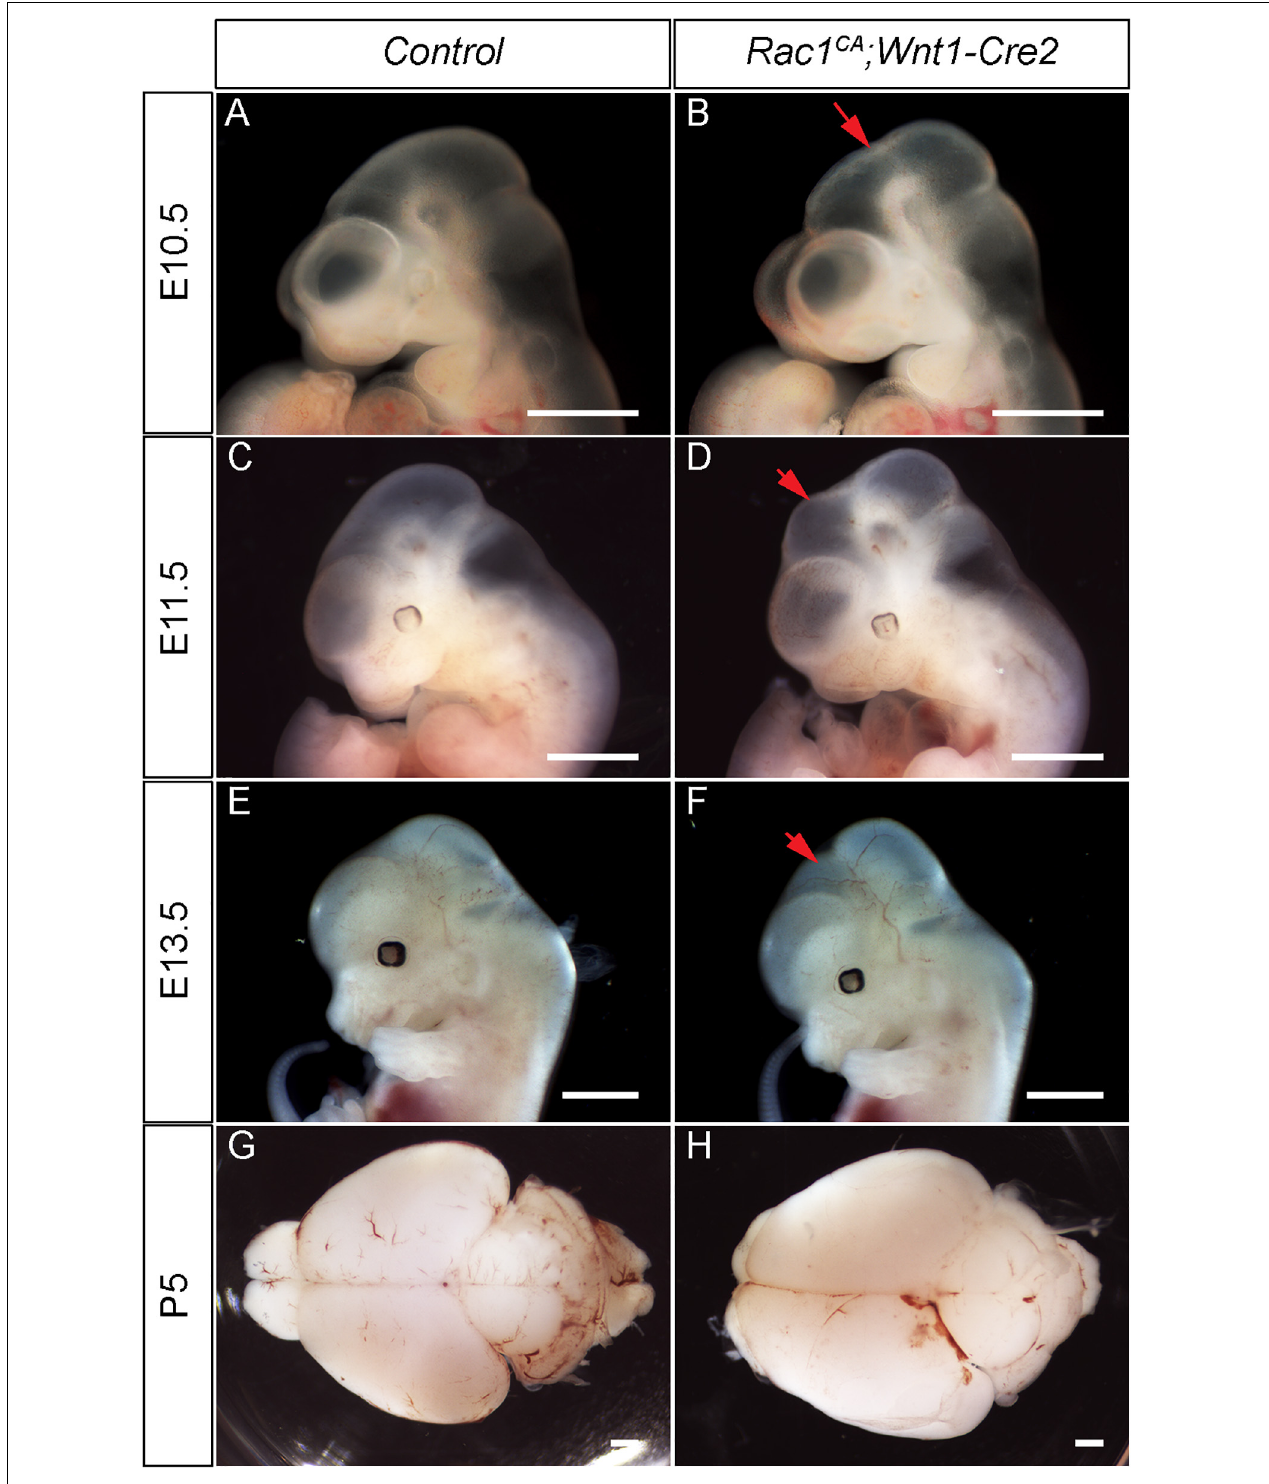
FIGURE 2 | Dysregulated Rac1 activity leads to abnormal neural crest development and midbrain malformation. (A–F) Lateral view of the control (A,C,E) and Rac1 CA ;Wnt1-Cre2 (B,D,F) embryos at E10.5 (A,B) , E11.5 (C,D) , and E13.5 (E,F) . Red arrows in B,D,F point to the midbrain of the mutant. (G,H) Whole-mount view of P5 brain of the littermate control (G) and Rac1 CA ;Wnt1-Cre2 (H) . Scale bar in A–H , 1 mm.